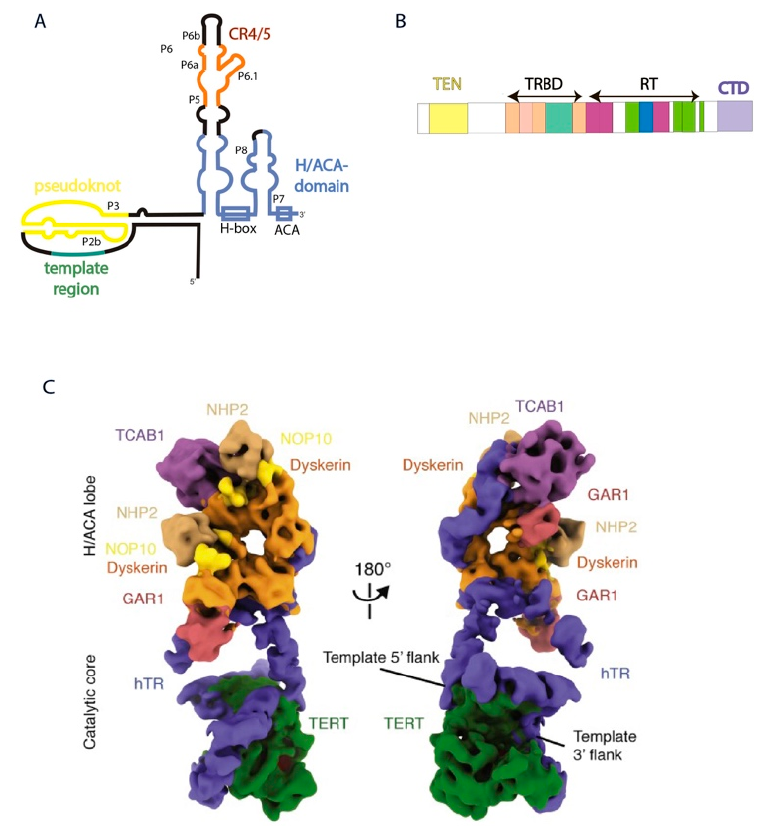
Figure 1. Human telomerase structure. ( A ) Secondary structure of hTERC. ( B ) Domain architecture of hTERT. ( C ) Cryo-EM structure of the human telomerase holoenzyme in two views [26] (Adapted with permission from Elsevier). Subunits are colored as labeled.